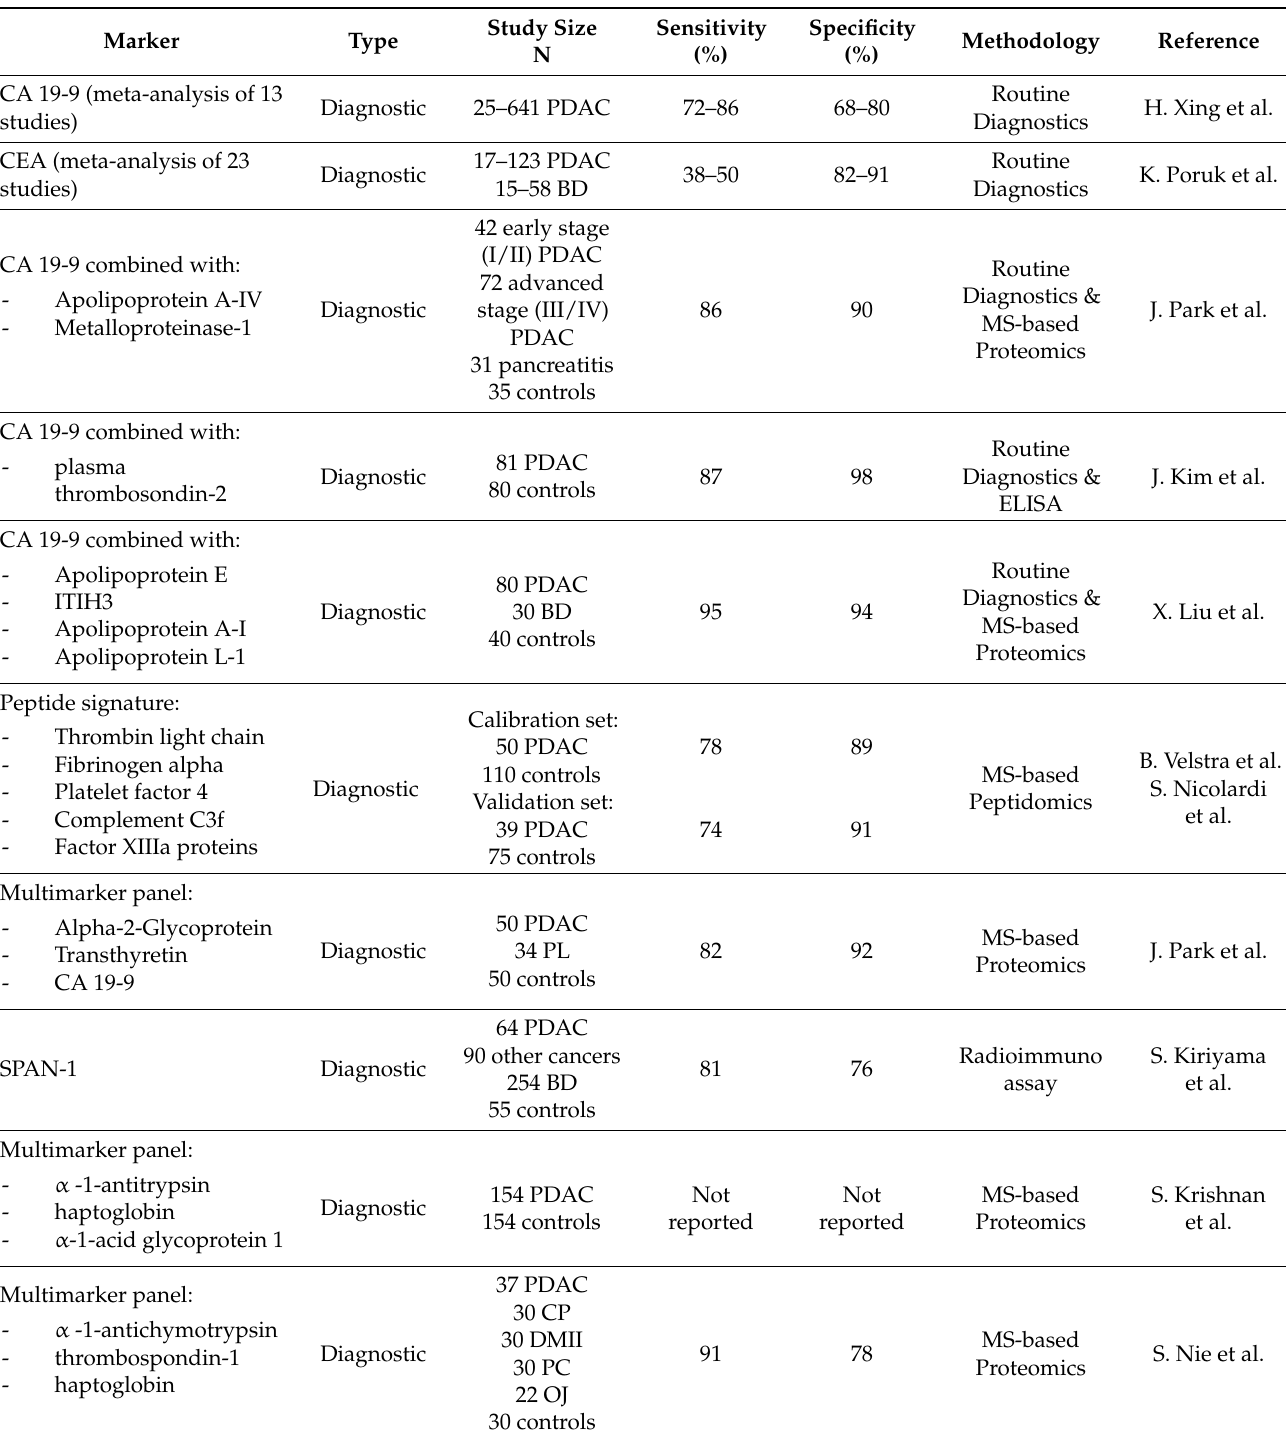
Table 1. Overview of diagnostic, prognostic, and predictive